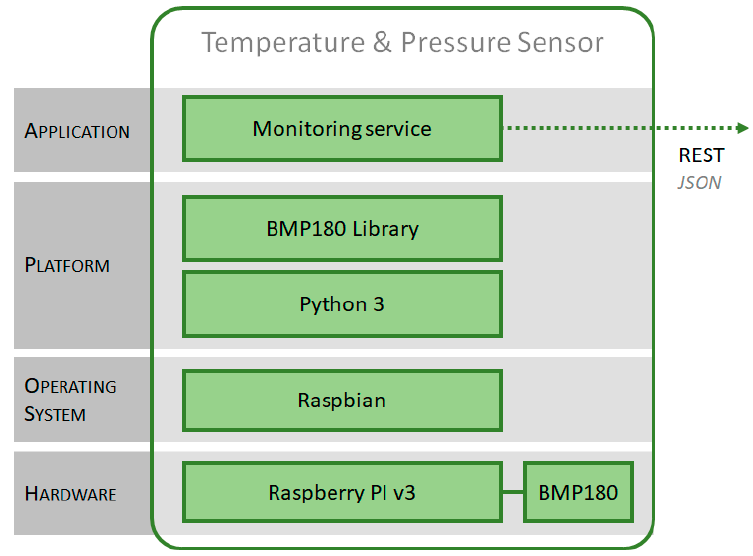
Figure 11. Architecture of context monitoring system.